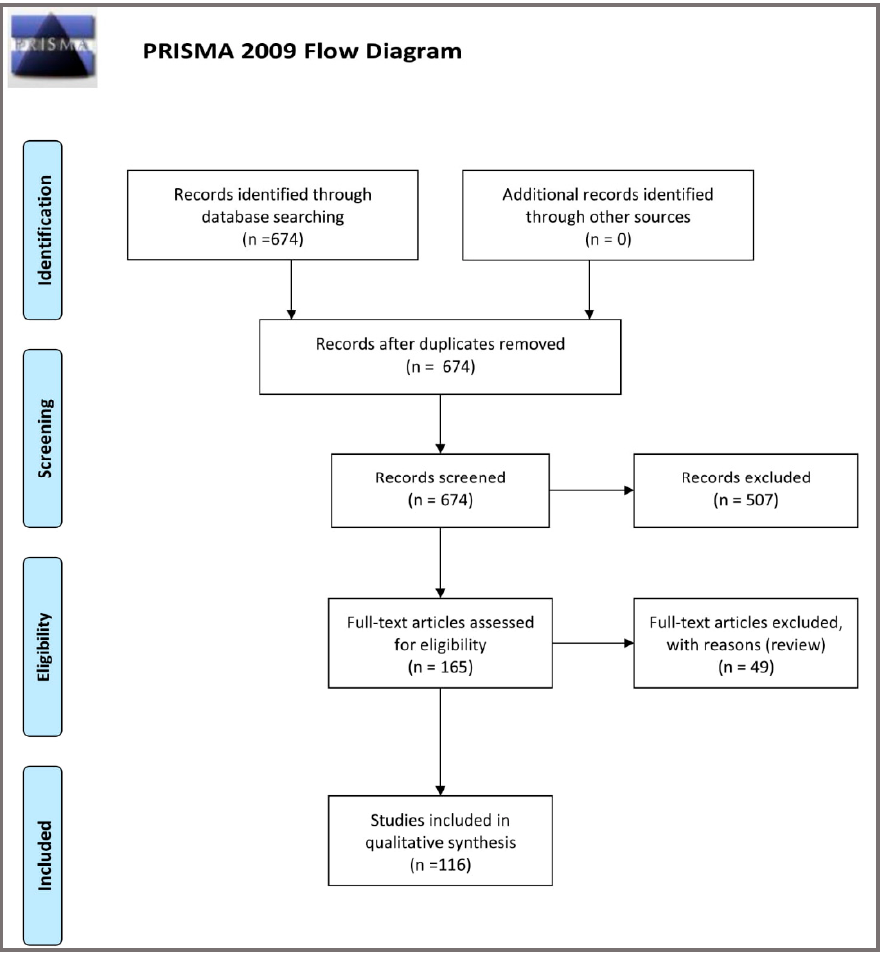
Figure 1. Schematic illustration of articles included in the review manuscript [31]